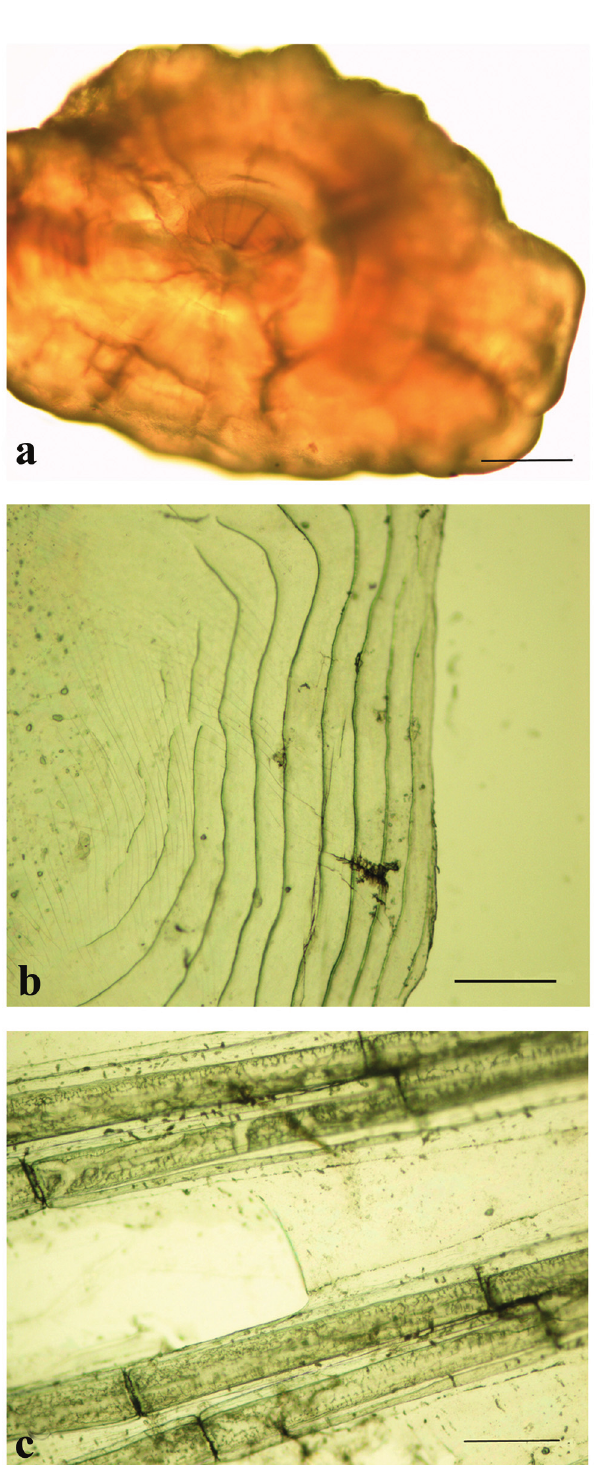
Fig. 1. Photographs of untreated pejerrey analyzed structures (30 days after experimental conditions): sagitta otolith ( a ), scale ( b ), caudal fin rays ( c ) under light microscope. Scale bar = 200